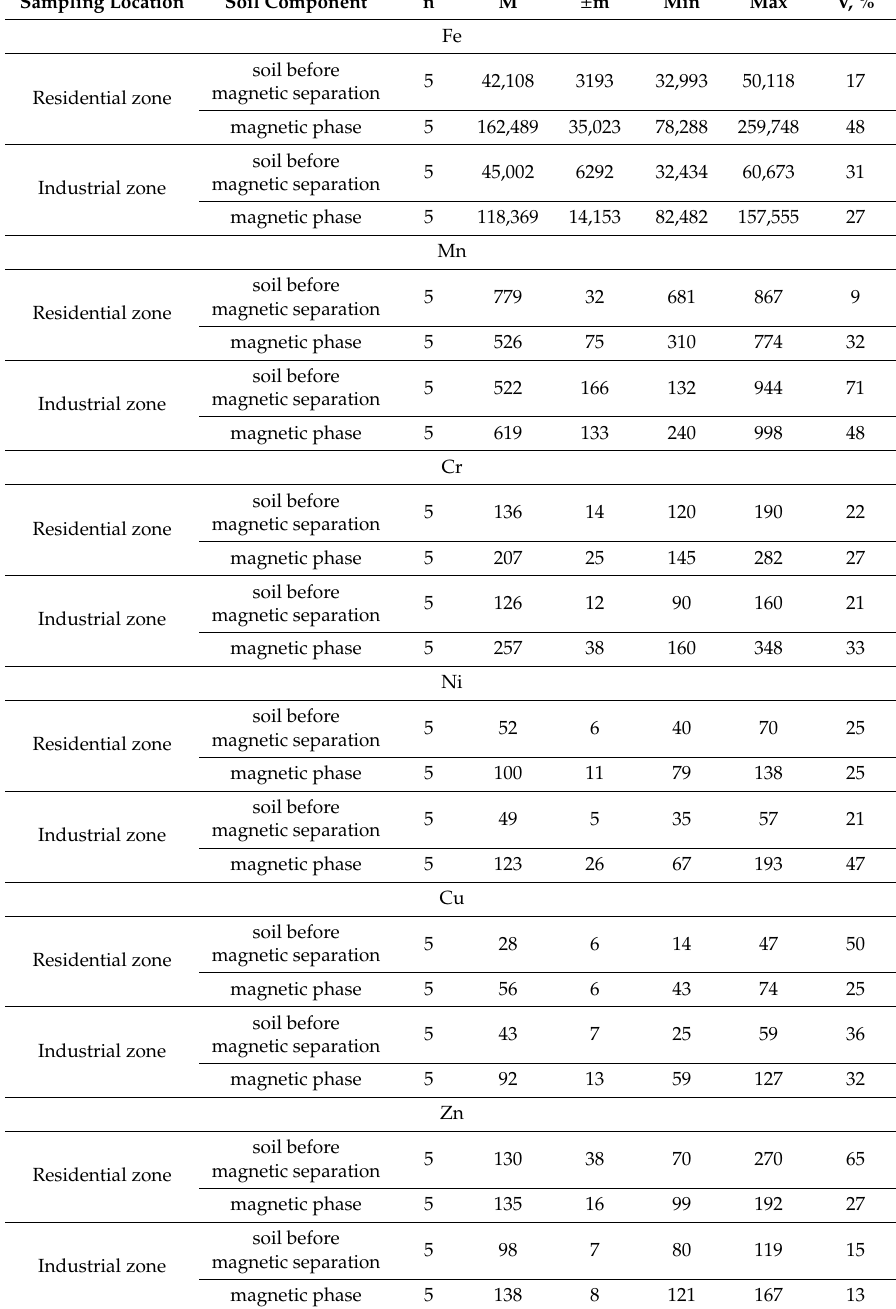
Table 10. Statistical indicators of the content of chemical elements of the upper soil horizons (0–10 cm) of Gubakha ( p = 0.05),